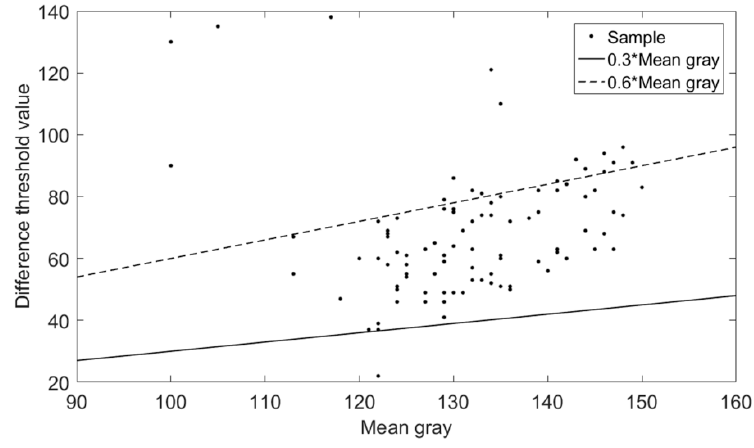
Figure 5. The selection of difference coefficient.